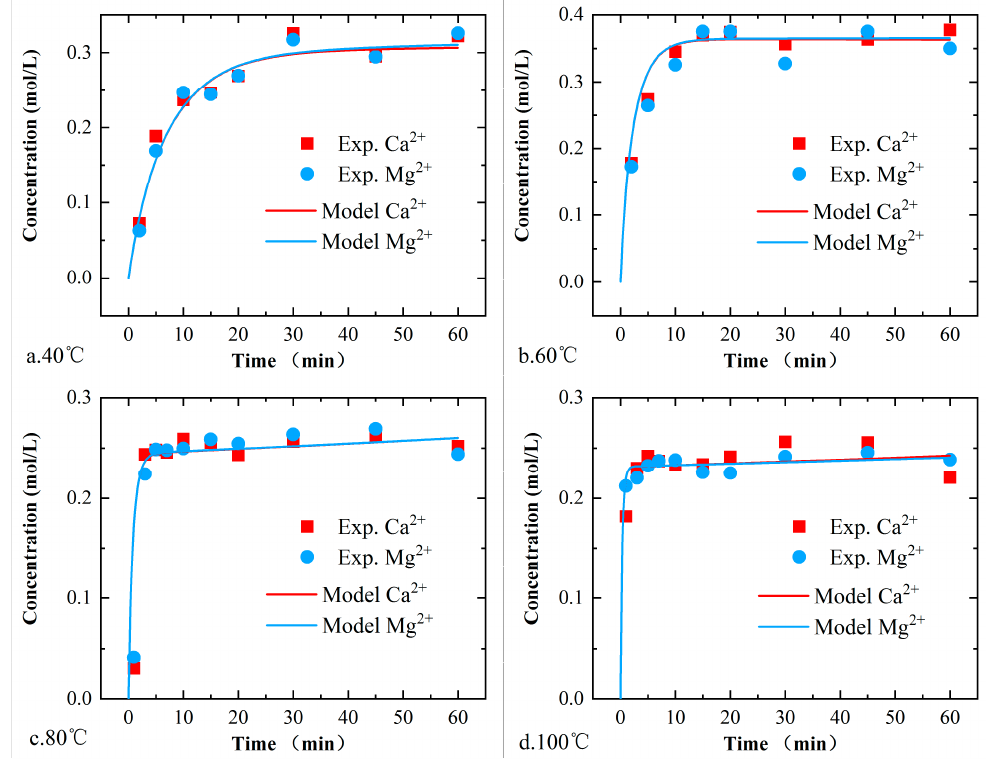
Figure 10. Comparison of Ca 2+ and Mg 2+ concentrations for core R2. The simulated changes in the Ca (cid:2870)(cid:2878) and Mg (cid:2870)(cid:2878) concentrations for core R1 are shown in Figure 11. The mineral composition of core R1 was more complex than that of core R2. In addition to dolomite, there were other soluble minerals such as calcite and clay minerals.